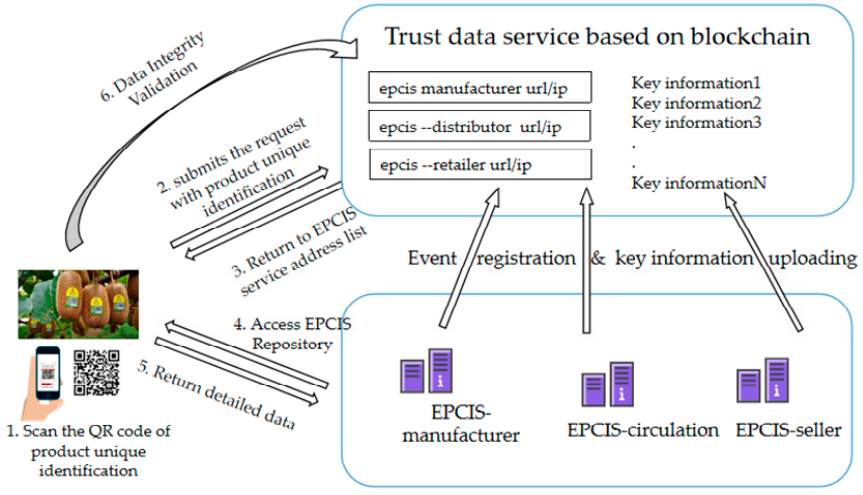
Figure 11. Product traceability resolution process.